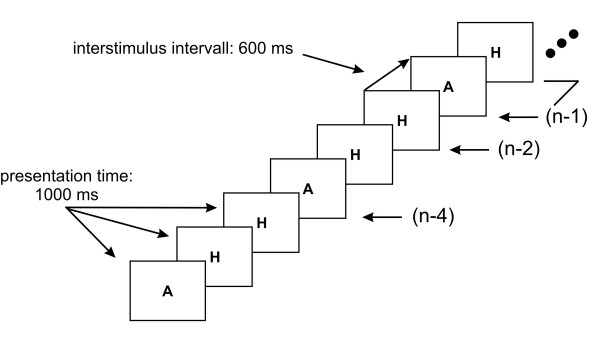
Time scheme of experiment 4. The n-back task contained a letter sequence and subjects had to indicate if the letter in the present step "n" was the same as the one before in step "n-1" or "n-2".